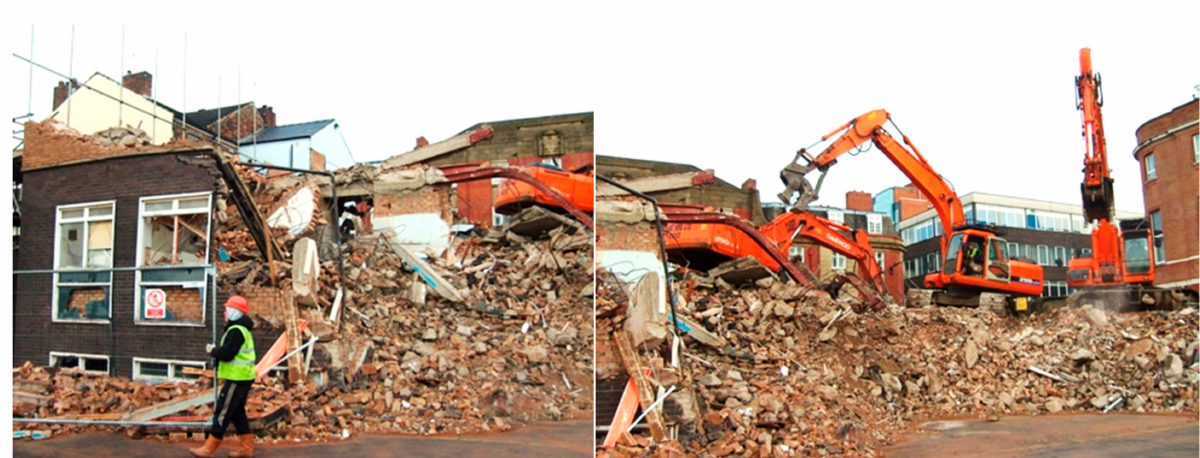
Figure 1. Exemplary European demolition site (photo by J.